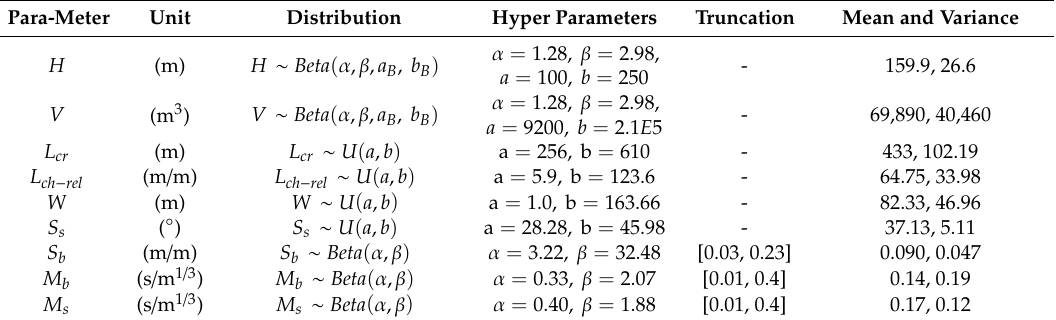
Table 6. Information about the marginal distributions specified for the input of the metamodel.